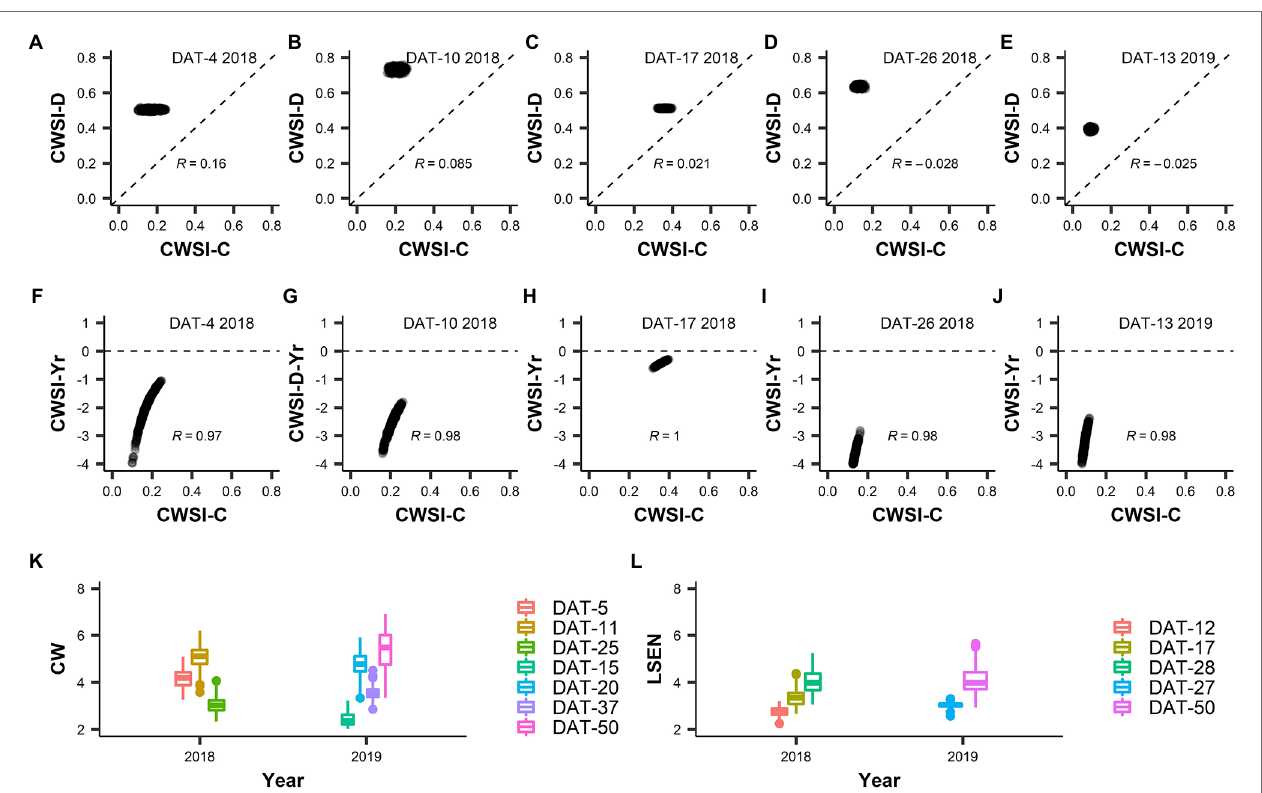
FIGURE 5 | Crop Water Stress Index (CWSI), Canopy wilting (CW) and Leaf senescence (LSEN). (A–E) present the correlation of CWSI values between control and drought treatments. (F–J) present the correlation between CWSI drought index values (Yr) and values obtained in the control treatment for CWSI. In data labels, “DAT” is measurement day after drought treatment initiation, “2018” and “2019” represent the year of experiment and “R” value is the Pearson’s correlation coefficient. Legends in (K,L) represent the measurement days (DAT) for CW and LSEN,